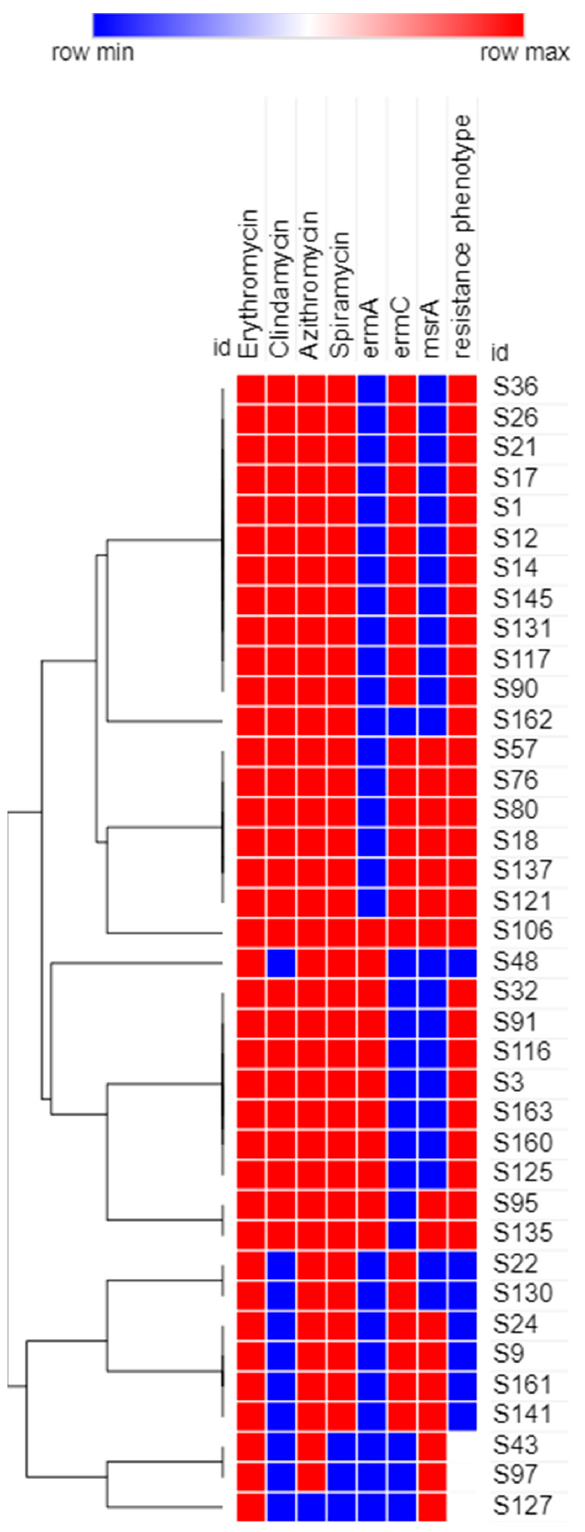
Figure 5. Dendrogram heatmap of MRSA isolates (n = 38) in the study based on their antimicrobial resistance patterns, and resistance genotypes and phenotypes. This heatmap was generated using Mor- pheus online software with Euclidean distances (https://software.broadinstitute.org/morpheus/, accessed on 14 April